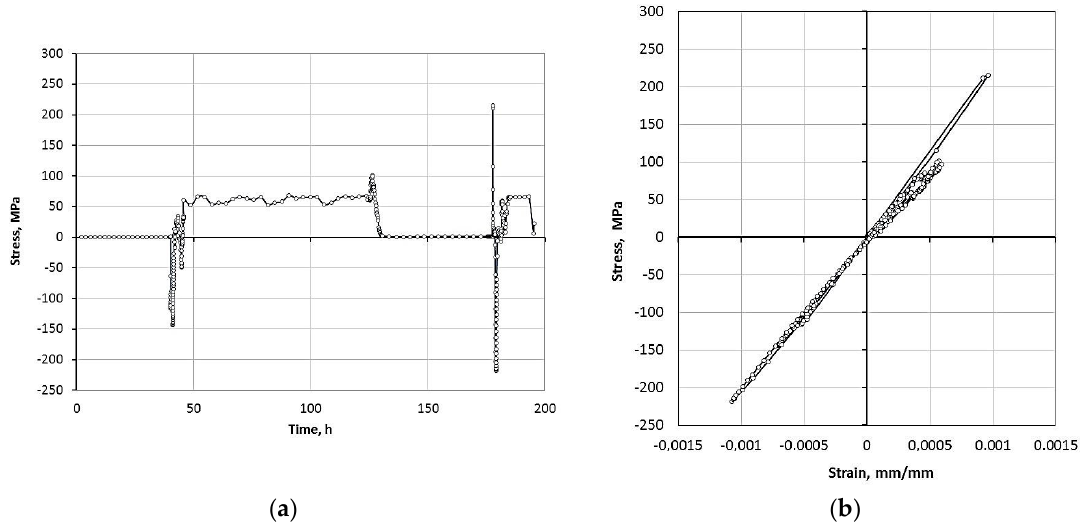
Figure 15. Temporal changes of the normal “z” component of the stress tensor ( a ) and the corresponding relationships between the normal “z” component of the total strain and stress tensors ( b ) (calculated for point A—Figure 14b, obtained on the basis of calculations of the Nu number with local modification(3000 W/m 2 K).